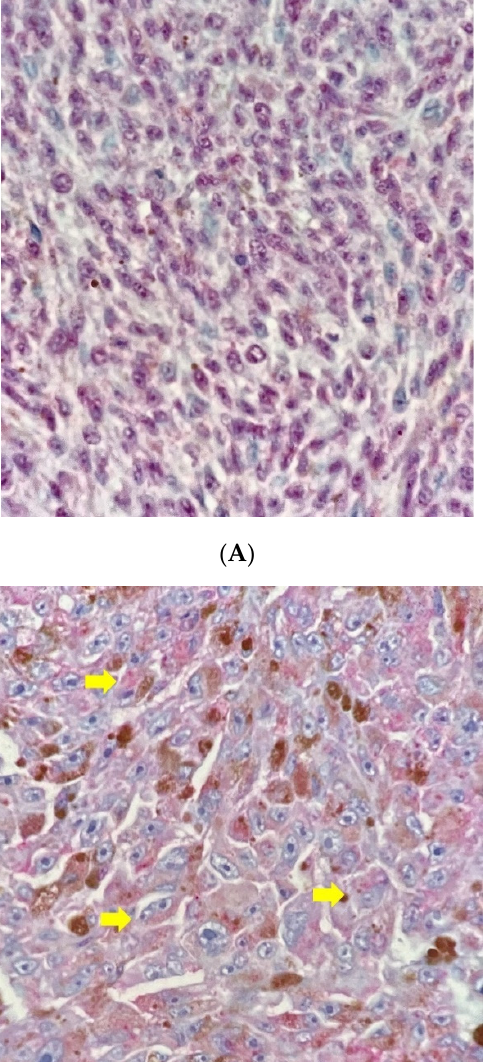
Figure 2. Nuclear BAP1 staining. ( A ) Grade 0 = positive staining in less than 10% of cells per high-power field (×400). Negative nuclear stain (black arrows) and lymphocytes used as positive control (white arrow). ( B ) Grade 1 = positive staining between 10% and 33% of cells per high-power field (×400). Negative nuclear stain (black arrows) and positive nuclear stain (yellow arrows). ( C ) Grade 2 = positive staining between 34% and 66% of cells per high-power field (×400). Negative nuclear stain (black arrows) and positive nuclear stain (yellow arrows) ( D ) Grade 3 = positive staining in ≥ 66% of cells per high-power field (×400). Negative nuclear stain (black arrows) and positive nuclear stain (yellow arrows).